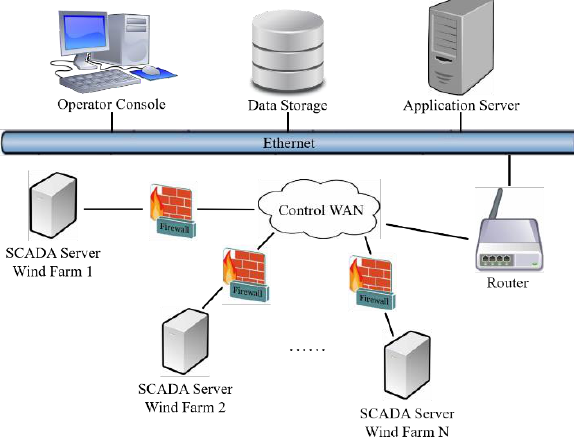
Figure 2. Representative architecture of wind energy management system (EMS) system.